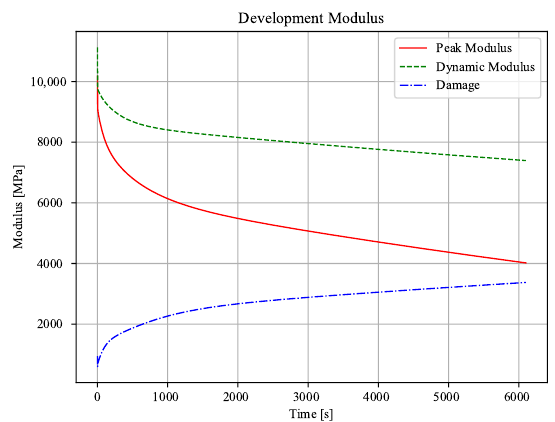
Figure 9. Development of moduli with cyclic load (stress amplitude